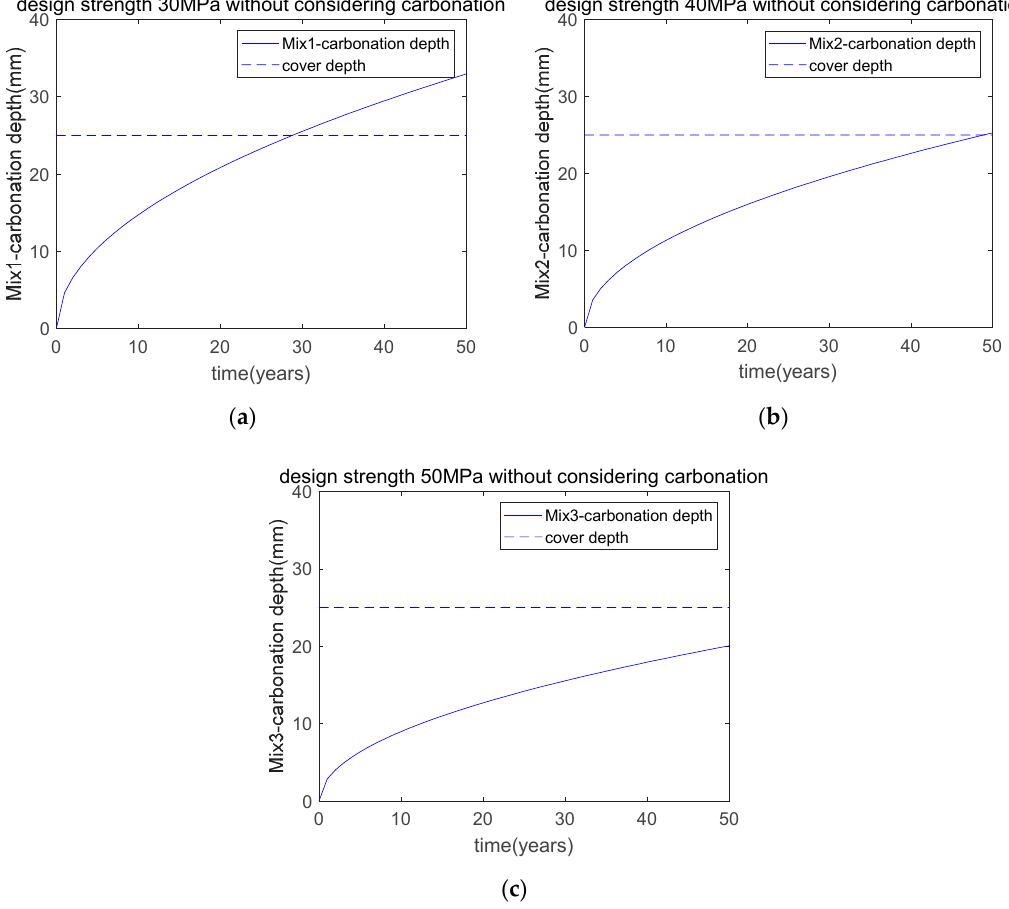
Figure 7. Carbonation depth of concrete without considering carbonation. ( a ) carbonation depth of Mix1; ( b ) carbonation depth of Mix2; ( c ) carbonation depth of Mix3.